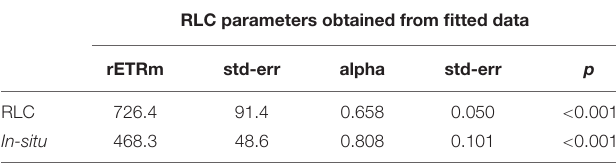
TABLE 1 | Fit parameters [obtained using the model of Webb et al. (1974) for the composite RLC shown in Figure 11 ]. RLC parameters obtained from fitted data